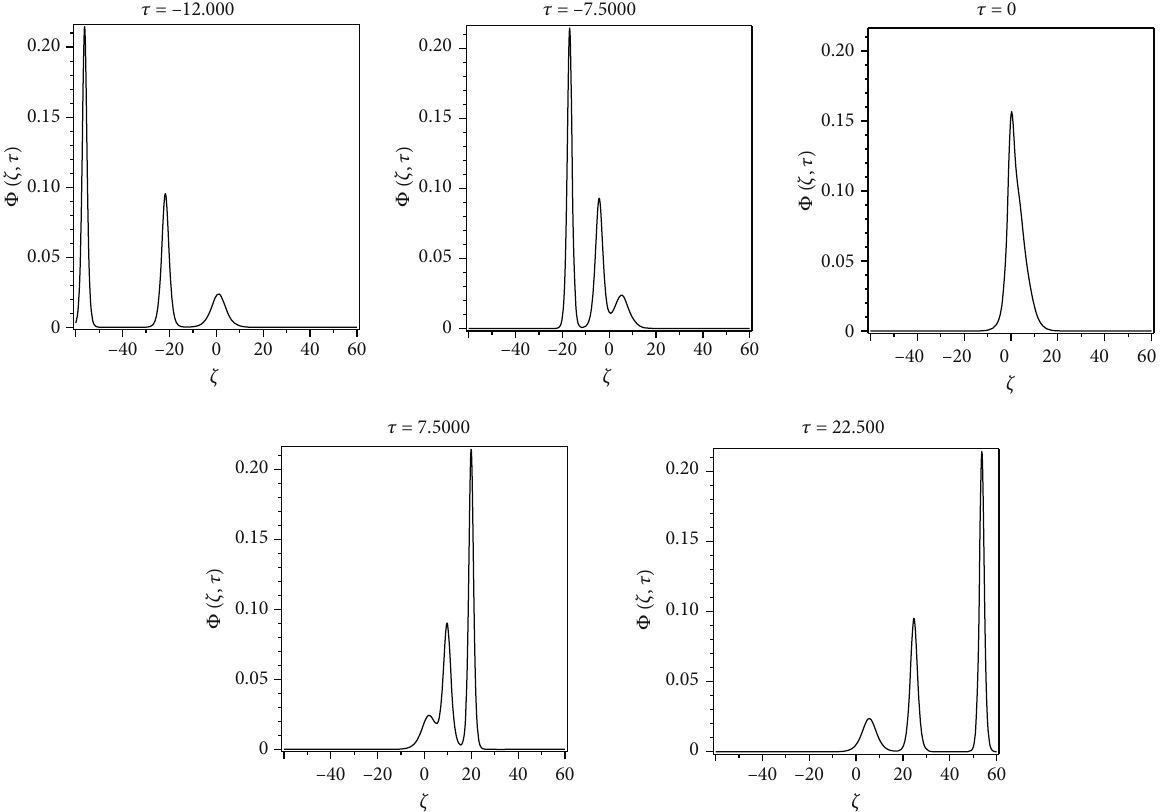
= 0 : 5 , k = 1 , and k = 1 : 5 . 1 2 3